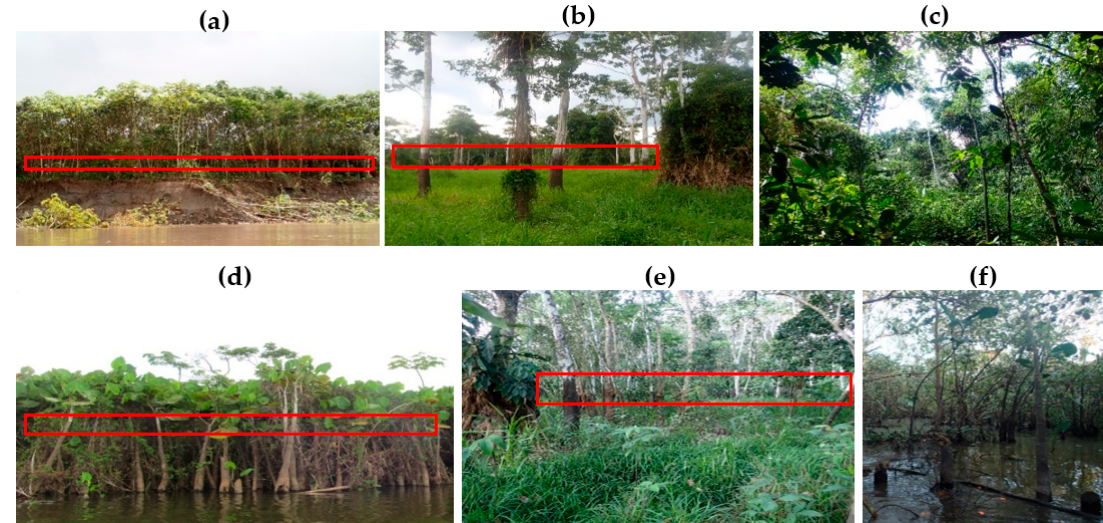
Figure 6. Variety of floodplains observed at study sites (shown in Figure 1b) in Pacaya Samiria at low water season. ( a ) View of river bank near Site #1, ( b ) open area in Site #1(in Figure 1b) with sparse tree cover dominated by Pseudobombax munguba ; ( c ) Dense canopy cover found in Site #2 (in Figure 1b); ( d ) inundated aquatic shrub species ( Montrichardia arborescens ) found along margins of lake at Site #3(in Figure 1b); ( e ) denser tree cover and understory found in Site #3 (in Figure 1b); ( f ) inundated swamp found at Site #4 (in Figure 1b). Examples of high flood marks on trees (shown red rectangles) indicate the level of previous inundation.